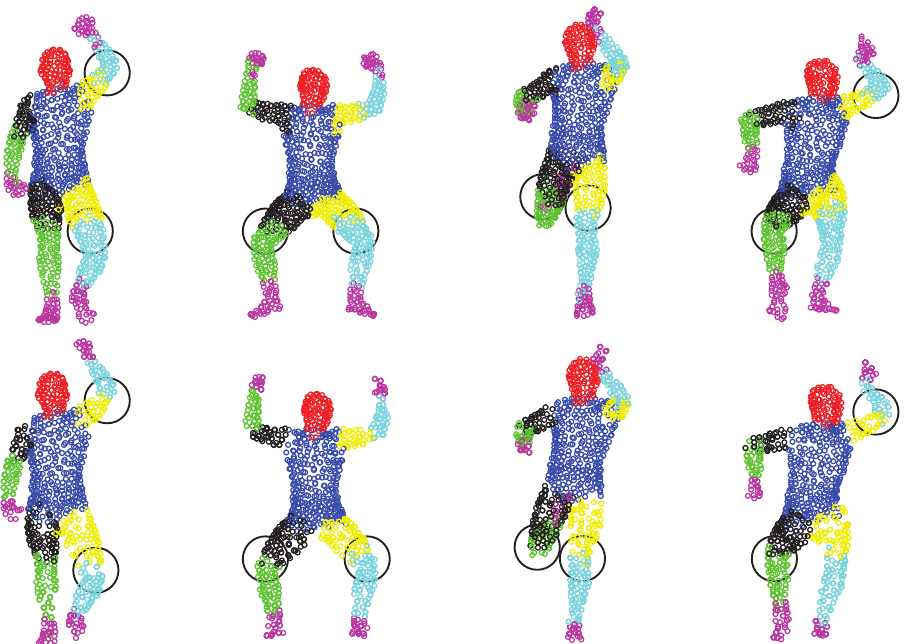
Figure 13. Results of correspondence refinement before (above) and after (below) SAICP, especially around limb joints (circled area).